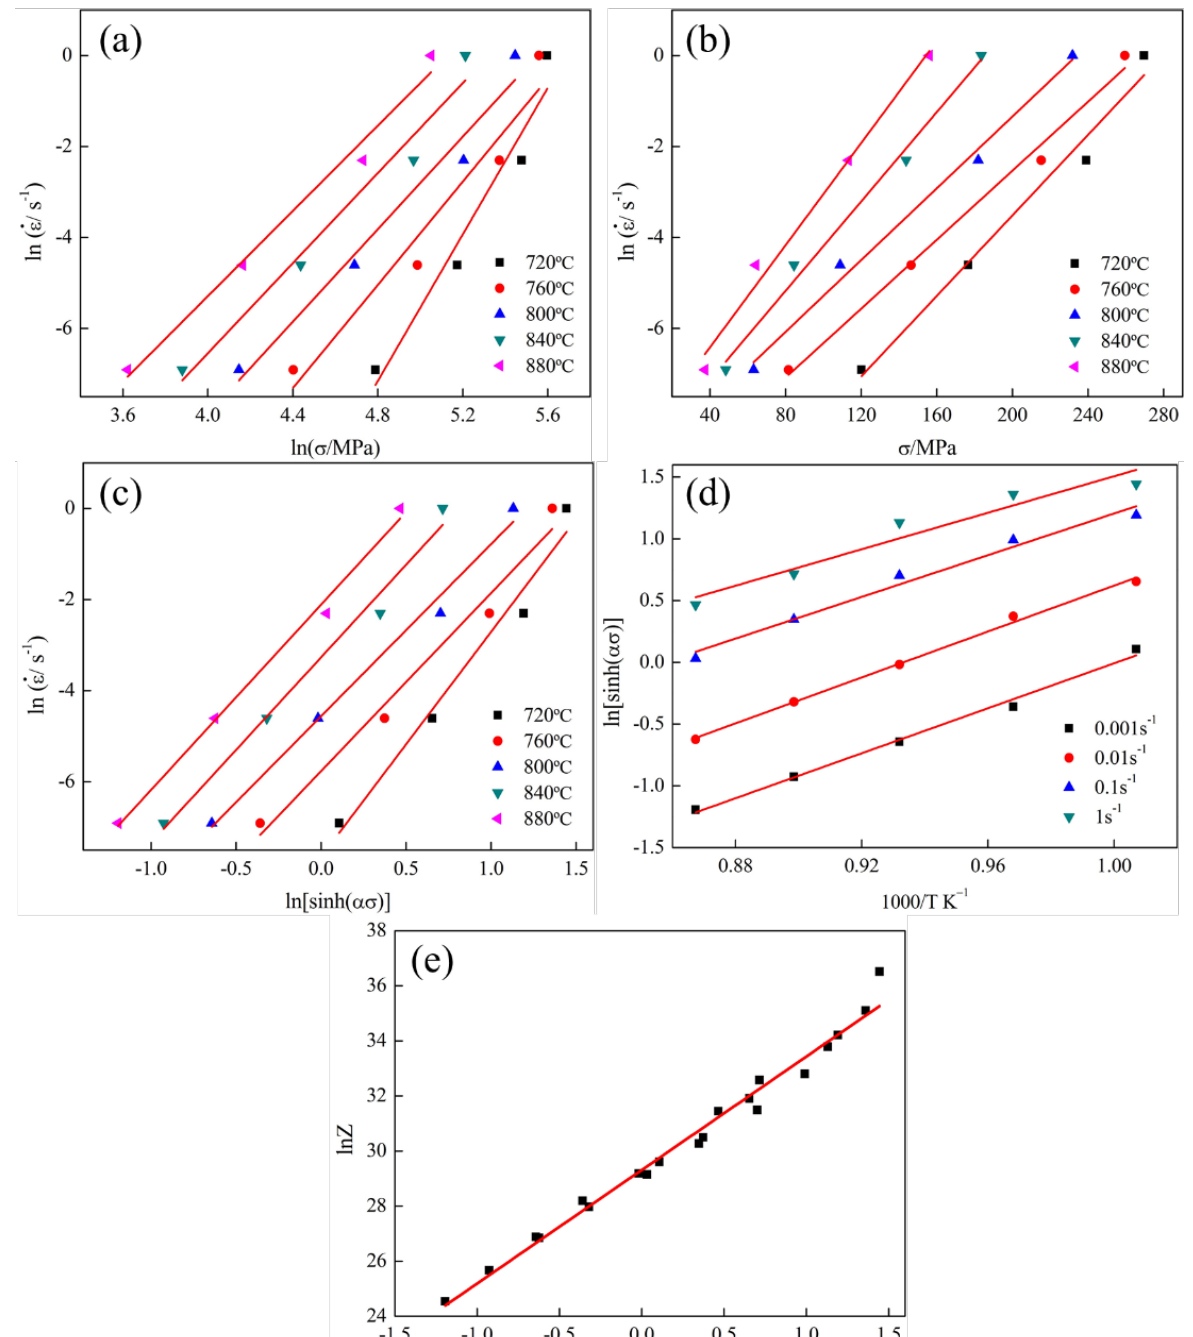
Figure 3. Plots of ( a ) ln . ε − ln σ , ( b ) ln . ε − σ , ( c ) ln . ε − ln [ sinh ( ασ )] , ( d ) ln [ sinh ( ασ )] − (1000/ T ), and ( e ) ln Z - [sinh ( ασ ) ]